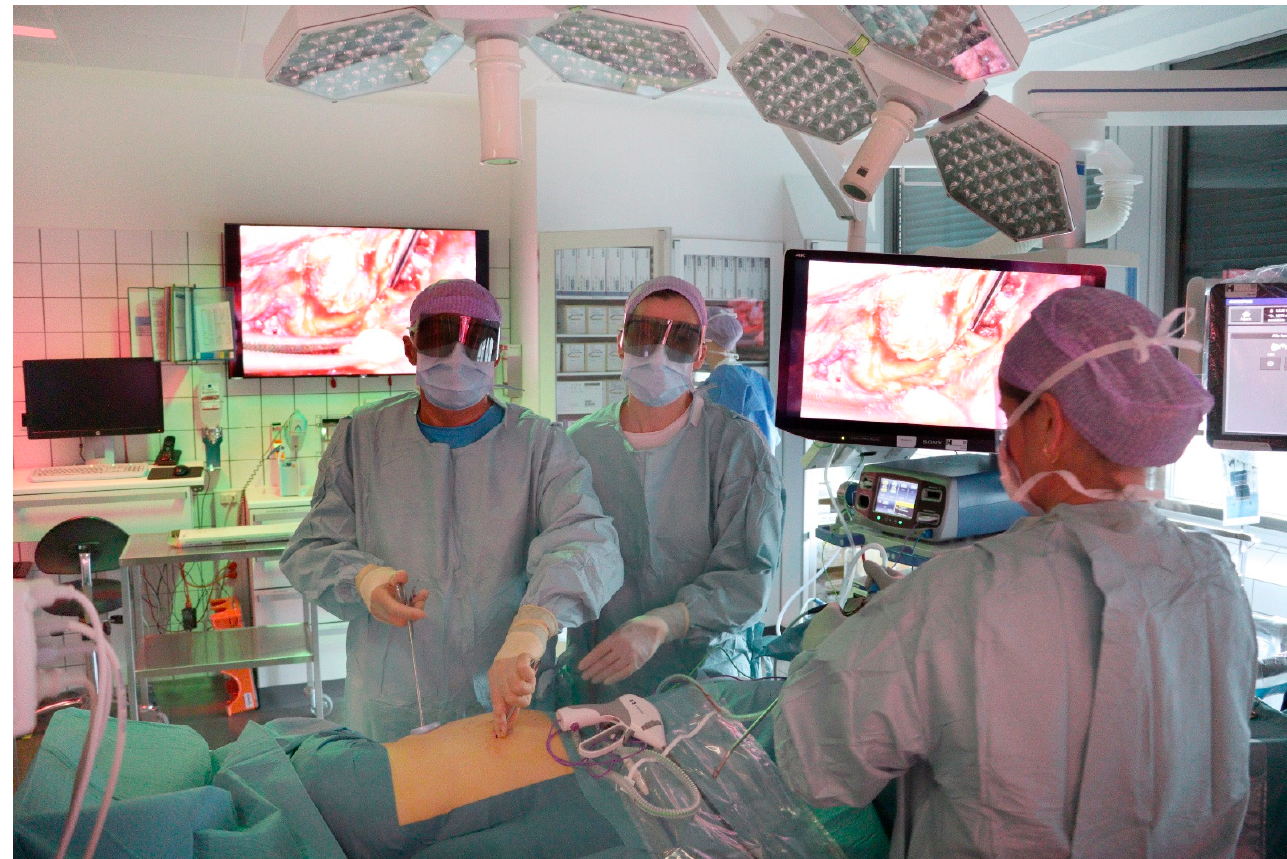
Figure 3. Modern VATS setup with advanced endoscopic instruments, 4K 3D monitors, and polarized 3D glasses.